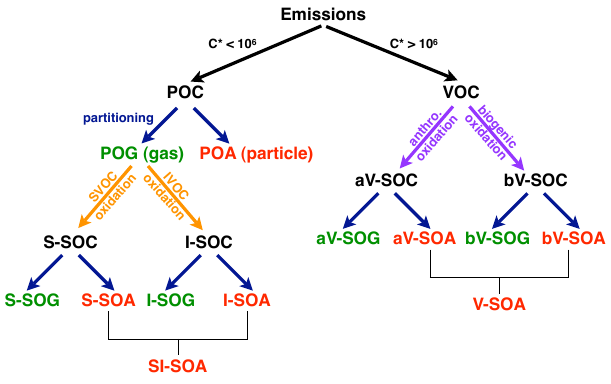
Fig. 2. Tree diagram of various classes of OA in the revised